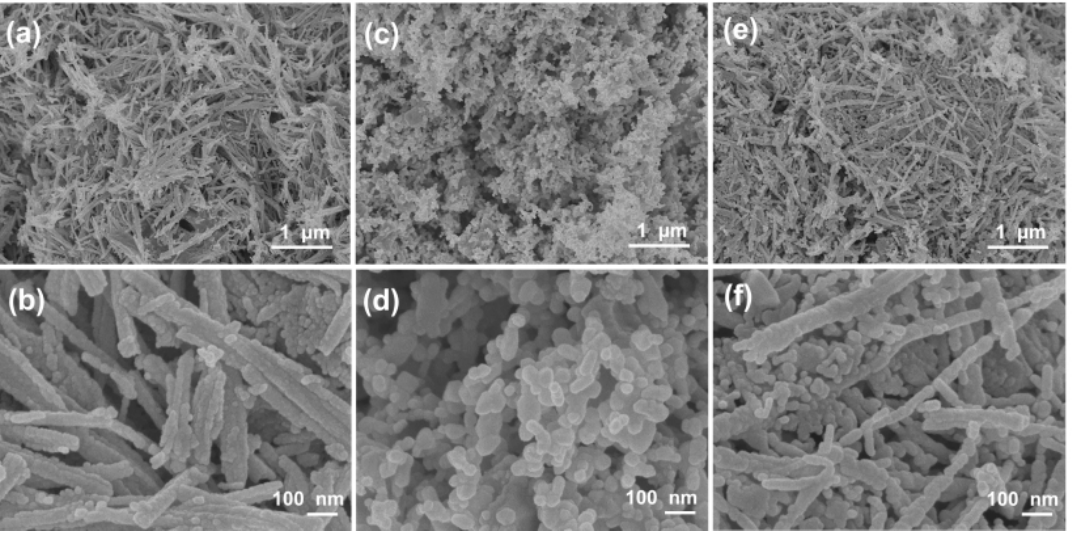
Figure 2. Scanning electron microscopy (SEM) images of ( a,b ) NiCo 2 O 4 , ( c,d ), CuCo 2 O 4 and ( e,f ) Cu 0.6 Ni 0.4 Co 2 O 4 .